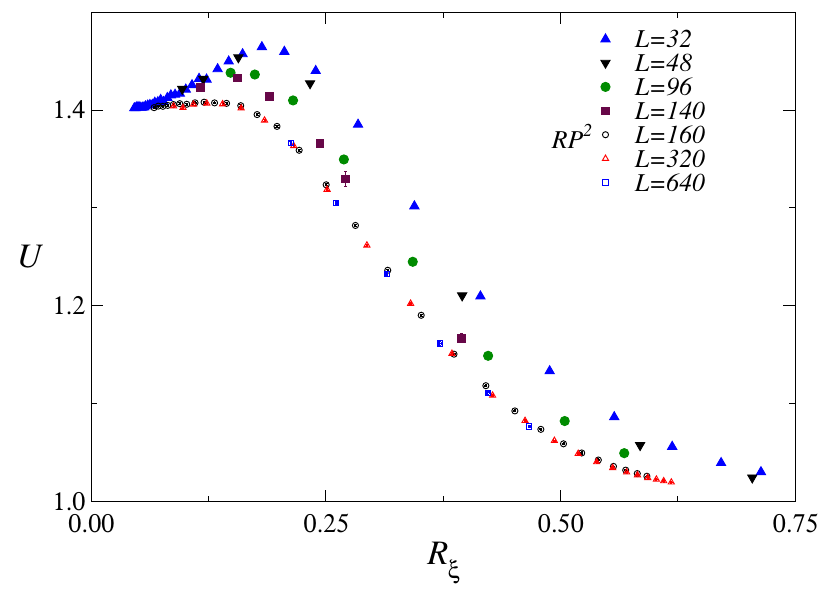
Figure 3 . Plot of U versus R ξ for N c = 3 , N f = 3 , v = 0 , and γ = 1 . Data are compared with analogous data on large lattices computed in the RP 2 model